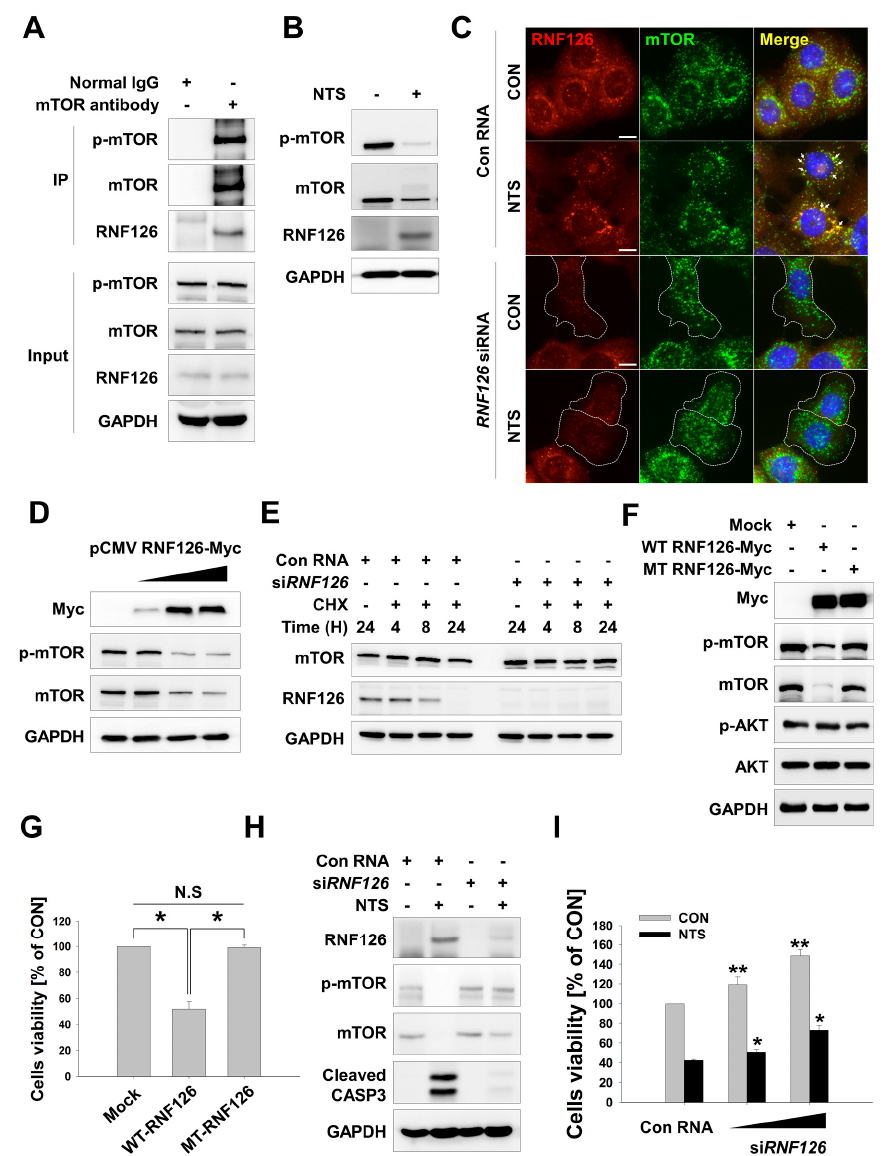
Figure 3. ‘Really interesting new gene’ finger protein 126 (RNF126)-induced mTOR downregulation. ( A ) Endogenous interaction between RNF126 and mTOR in leukemia cells as determined by immunoprecipitation assay. Normal IgG antibody was used as a negative control. ( B ) p-mTOR, mTOR or RNF126 protein expression in K562 cells treated with NTS and determined by Western blot. ( C ) Colocalization between RNF126 and mTOR in NTS-treated K562 leukemia cells. RNF126 (red) or mTOR (green) was stained with anti-RNF126 or anti-mTOR antibodies. Scale bar-10 μ m. ( D ) Downregulation of mTOR in RNF126-overexpressing K562 cells. RNF126 plasmids were transfected into K562 cells and after 24 hours, protein levels were assessed by Western blot. ( E ) Western blot of enhanced mTOR protein level in siRNF126 knock-down K562 cells. Cycloheximide (CHX, 50 µ g / ml) was pre-treated for 1 hour. ( F and G ) Western blot of mTOR downregulation and leukemia cell growth inhibition in K562 cells transfected with RNF126 wild type (WT) and E3 ligase inactive mutant (MT) ( F ) MTS assay showing cell viability in K562 cells transfected with RNF126 wild type (WT) and E3 ligase inactive mutant (MT) ( G , n = 6). ( H and I ) RNF126 knock-down a ff ects NTS-induced mTOR downregulation and cell death. RNF126 siRNA was transfected into K562 cells for 48 hours. After then, NTS was treated further 24 hours. Proteins level was evaluated by Western blot using each indicated antibodies ( H ) and cell viability was measured by MTS assay ( I , n =